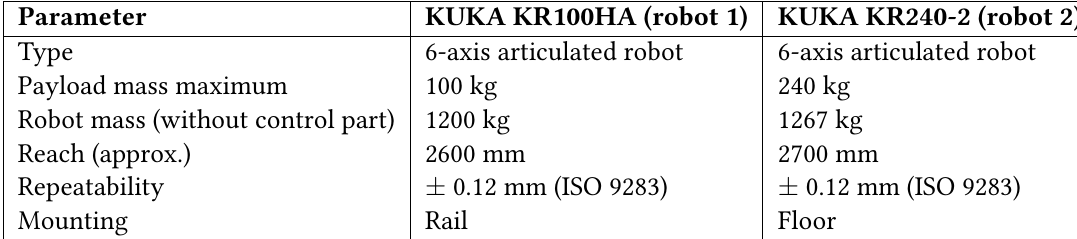
Table 2: Technical data of the